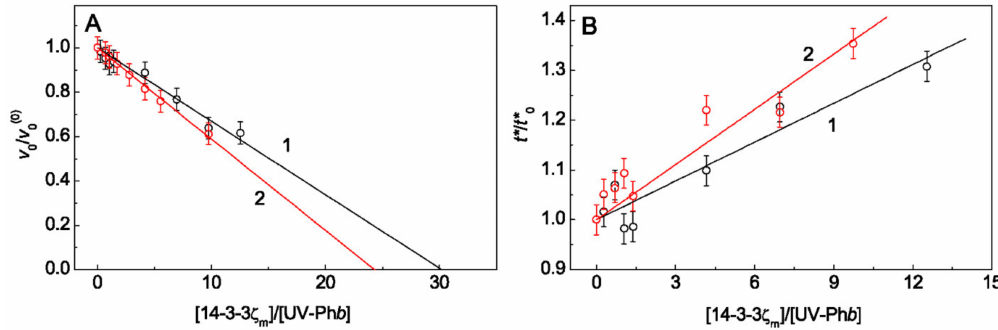
Figure 4. E ff ect of 14-3-3 ζ m on the kinetic parameters of UV-Ph b (0.25 mg / mL) aggregation in the absence and in the presence of 0.1 M Arg at 37 ◦ C. ( A ) The dependences of the relative initial rate of UV-Ph b aggregation at the stage of aggregate growth, v 0 / v 0(0) , and ( B ) the relative value of the nucleation stage duration, t* / t* 0 , on the ratio of molar concentrations of 14-3-3 ζ m and UV-Ph b . Points are experimental data. The solid lines in panel ( A ) are calculated from Equation (2). Curves 1 and 2 in panels ( A , B ) are obtained in the absence and in the presence of 0.1 M Arg,